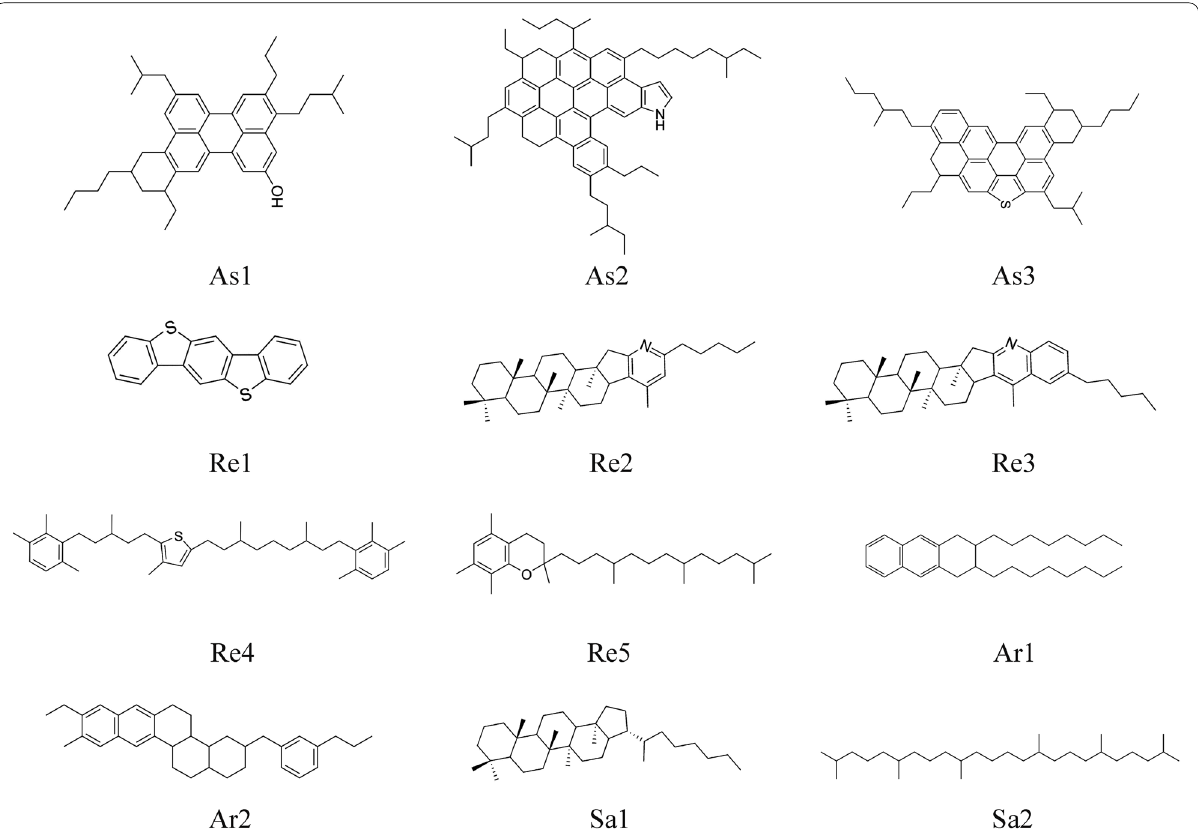
Fig. 3 12-Component Molecular Structures of Long-Term Aged Asphalt